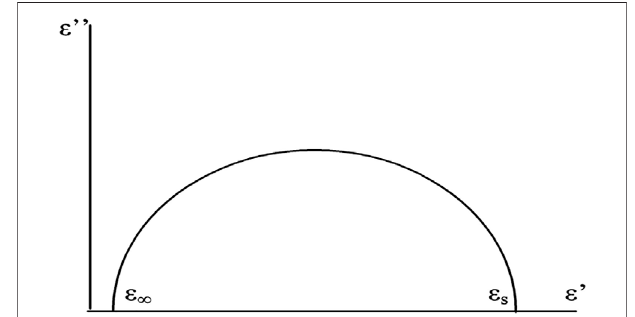
FIGURE 5 | Cole-Cole Plot showing the relationship between dielectric constant and dielectric loss.